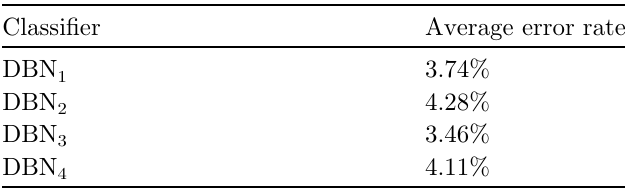
Table 3. Error rate of preliminary fault identi fi